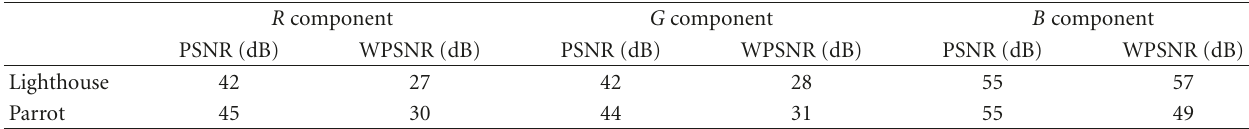
Figure 12: Equalization attack tested on a dictionary of 500 randomly generated watermarks: (a) blue component after equalization attack; (b) mutual information; (c) normalized Hamming distance. Table 1: Quality evaluation of the watermarked